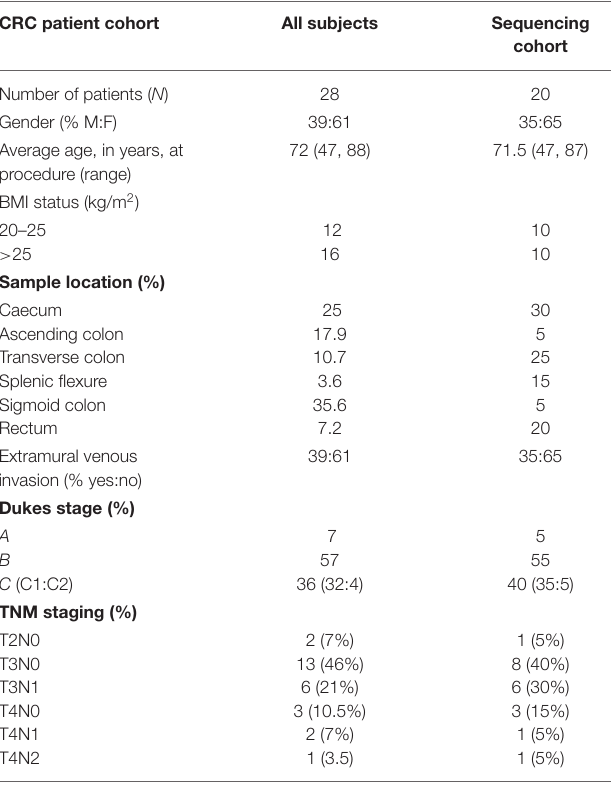
TABLE 1A | Study cohort information for patients with colorectal cancer. CRC patient cohort